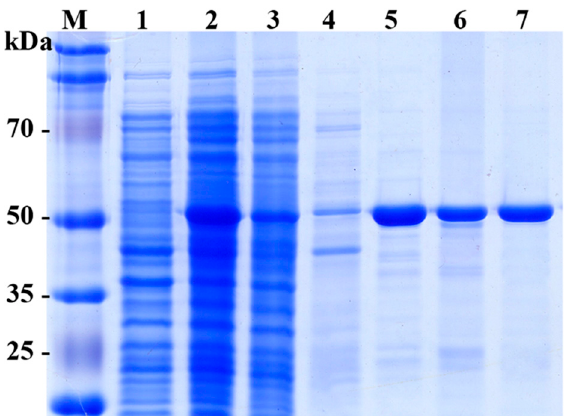
Figure 2. SDS-PAGE analysis of expression and purification of SpG6PD1. M: molecular weight